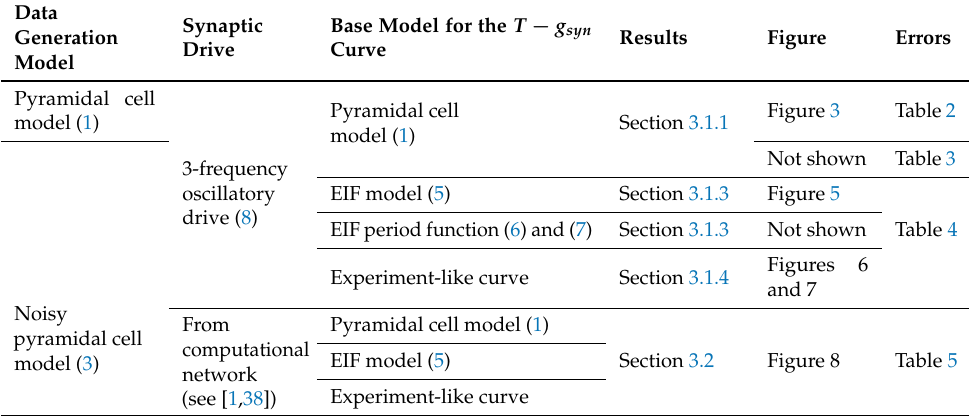
Table 1. Outline of the different cases studied in Section 3 ( Results ).